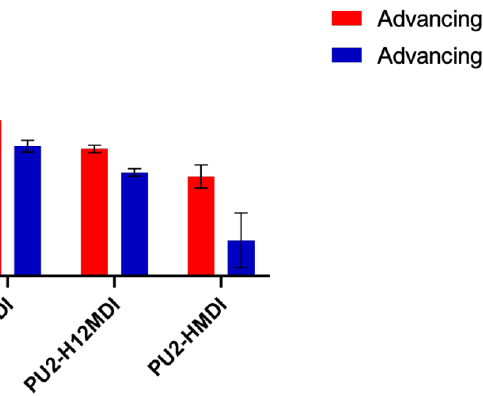
Figure 7. Advancing contact angles of polymers in the first and second cycle of immersion.